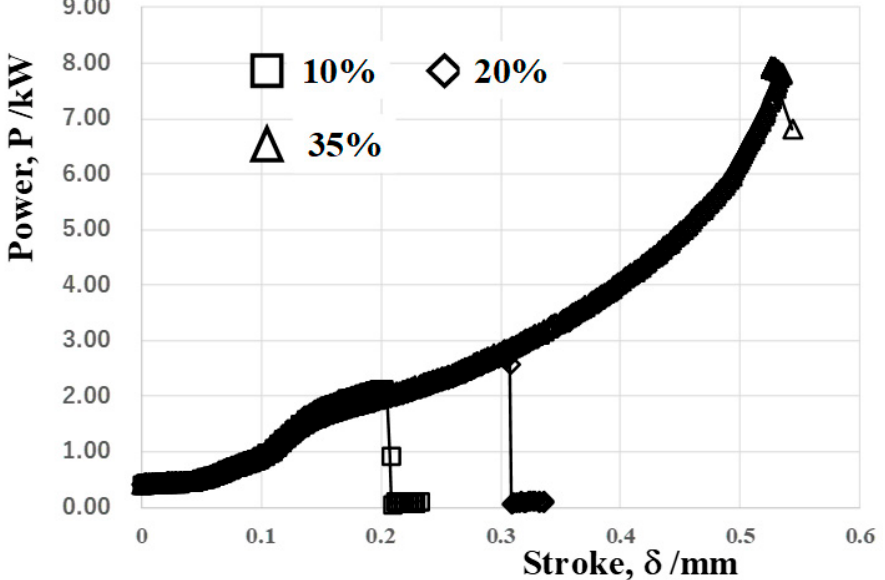
Figure 9. Power to stroke the relationship in the forging of the titanium wire with increasing the reduction of the diameter. reduction of the